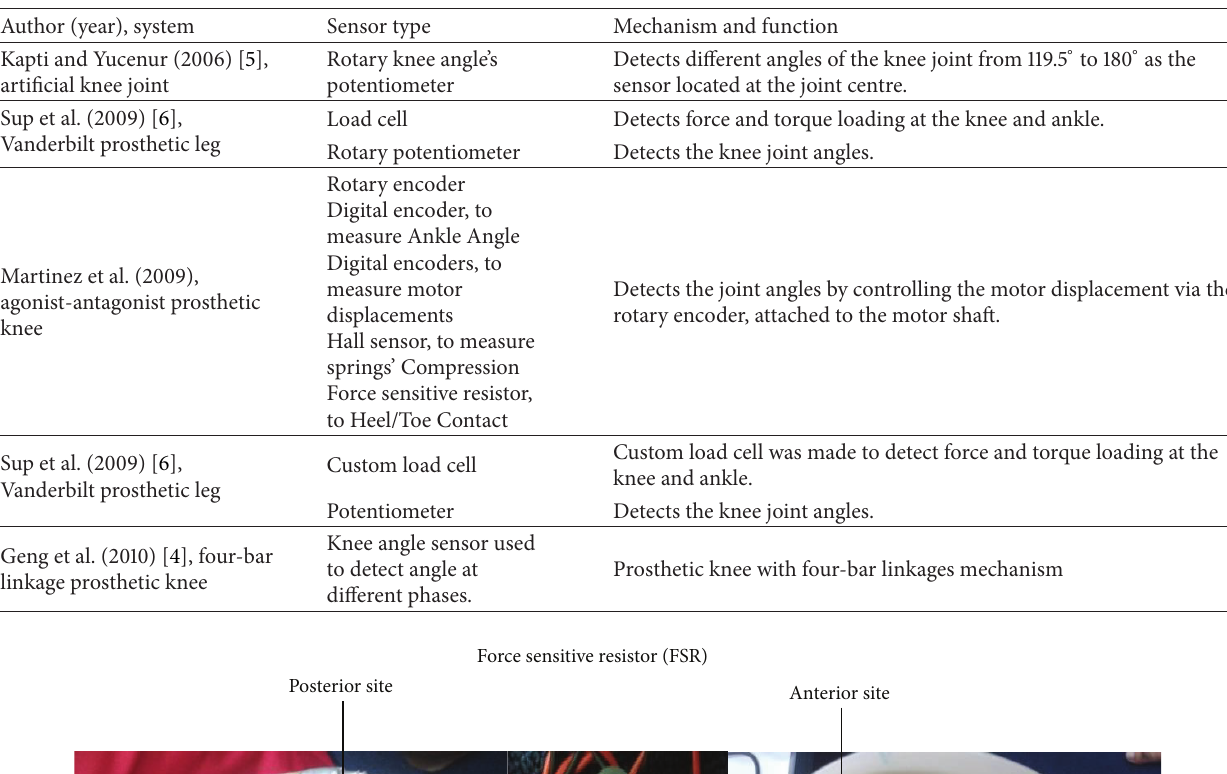
Table 1: Sensory mechanisms used in prosthetic knee systems.